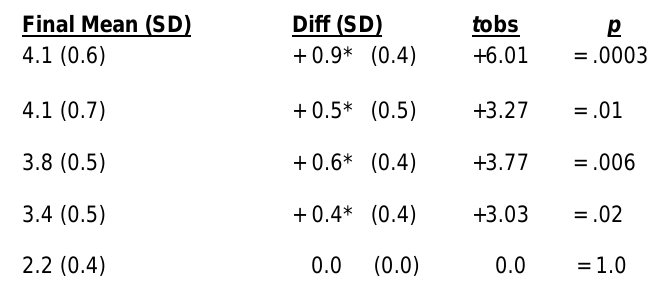
Table 5. ASHA – NOMS Changes in SCALE Participants with Chronic Aphasia following Remote Therapy & On-line Exercise